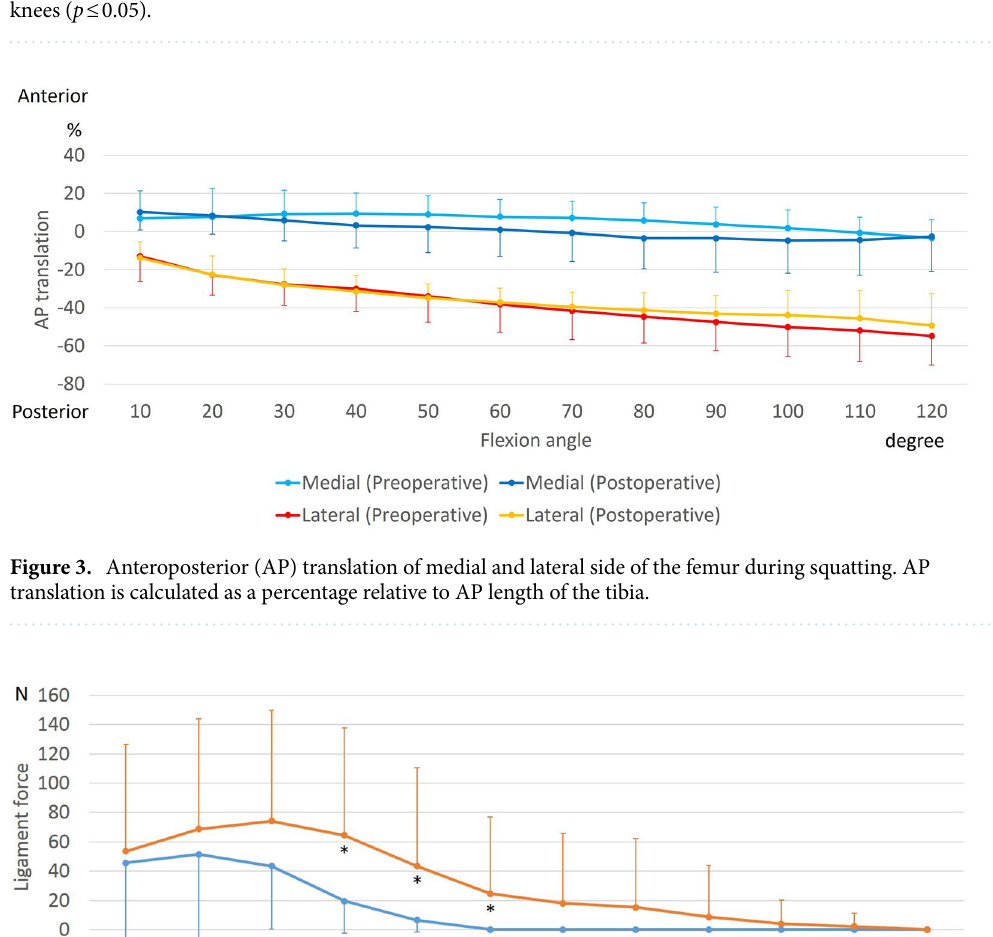
Figure 2. Varus–valgus angle during squatting. *Significant differences between preoperative and postoperative knees ( p ≤ 0.05).